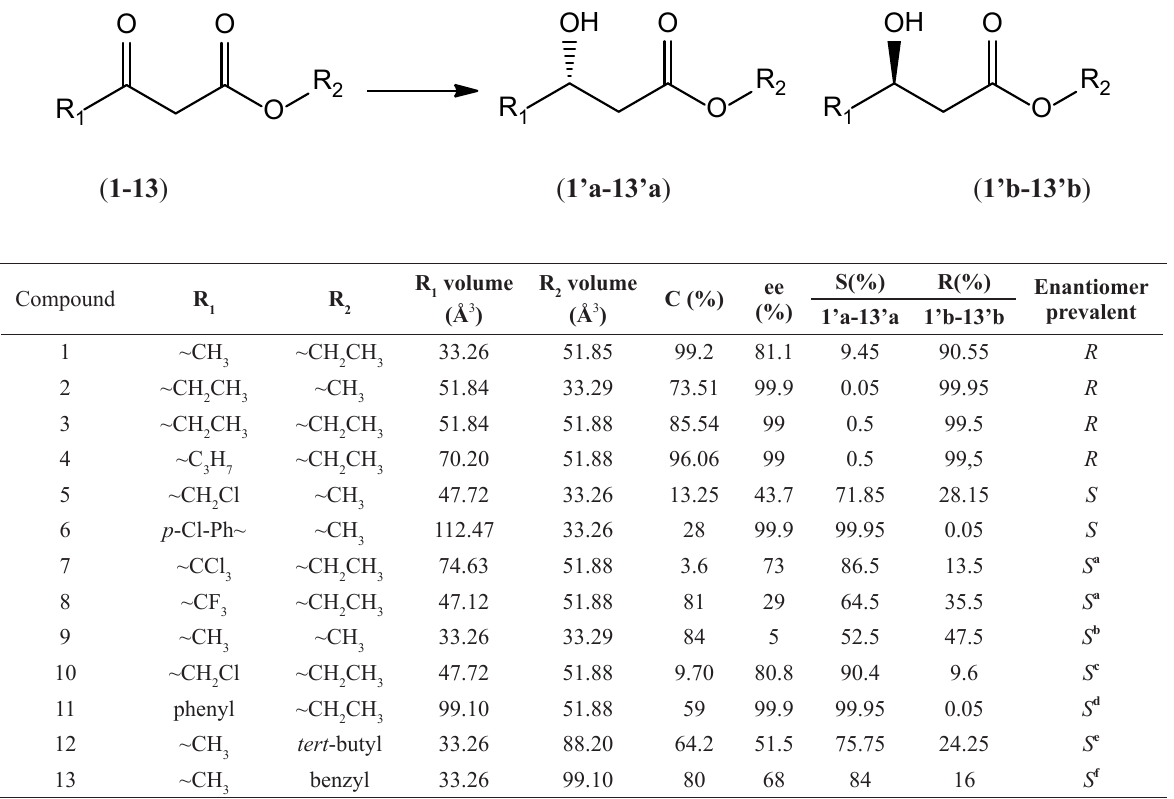
β-KETOESTERS: AN APPROACH FOR ASYMMETRIC BIOREDUCTION